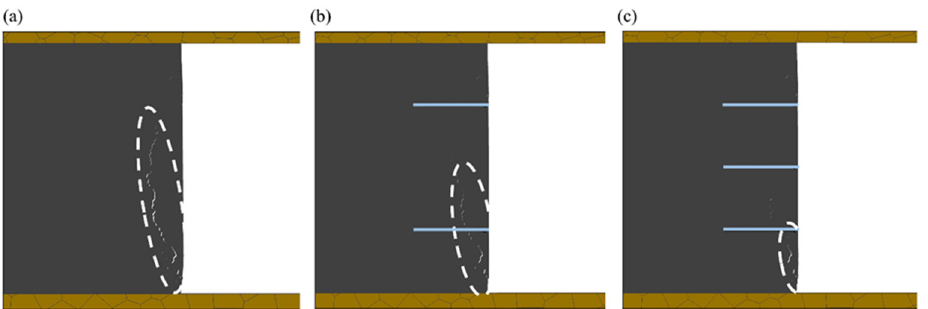
Figure 14. Macro-fracture development in the rib. ( a ) Unsupported; ( b ) 2-cable-bolted rib; ( c ) 3-cable-bolted rib at overburden depth of 250 m and contact strength reduction of 2.0.